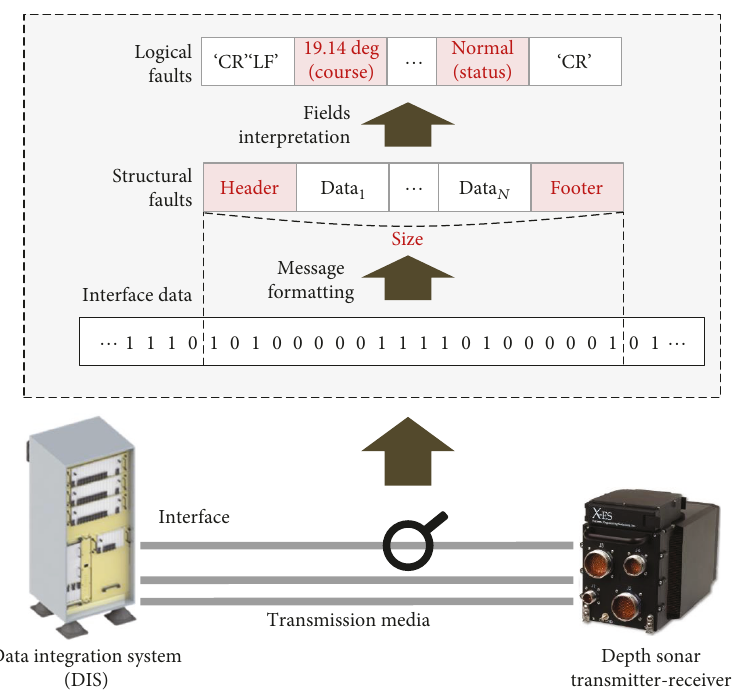
Figure 2: Classi fi cation of local faults in point-to-point link: structural and logical Table 1: Preinvestigated interface protocols in 2 types of submarines.